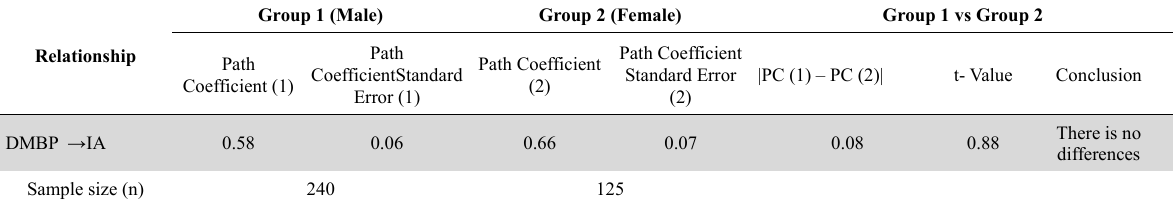
Evaluation on gender as moderator variable